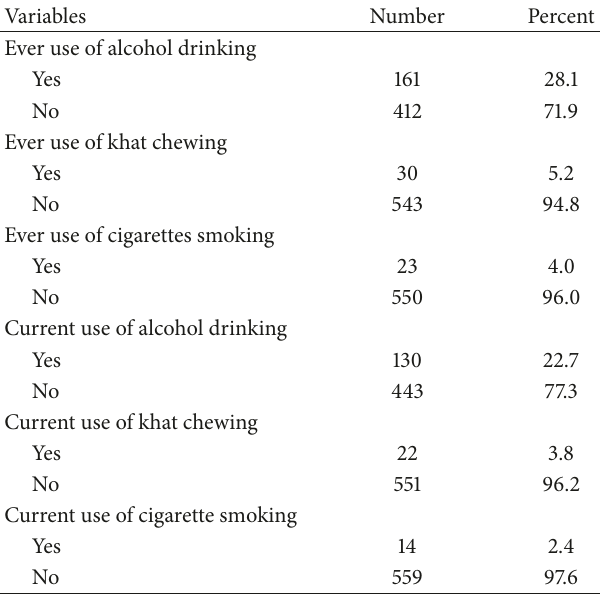
Figure 2: Distribution of suicide attempt methods by sex among adolescent high school students in Dangila Town, Northwest Ethiopia, 2015. Table 3: Frequency distribution of substance related factors among adolescent high school students in Dangila Town, Northwest Ethiopia, 2015.